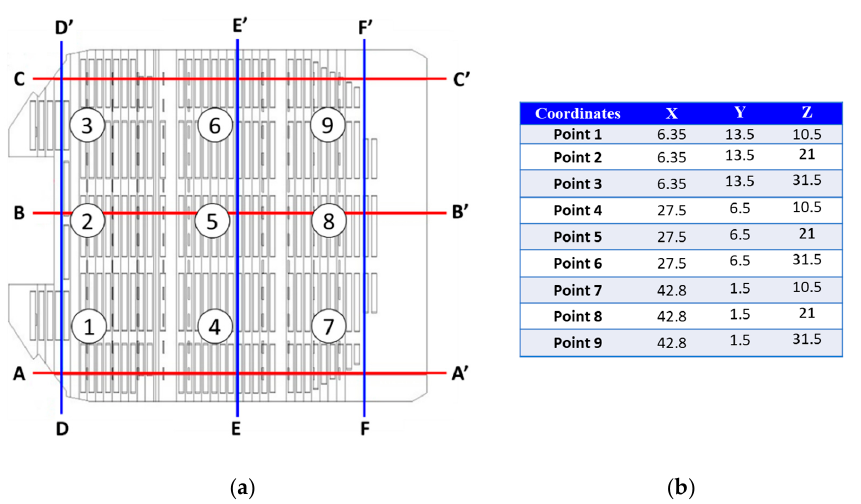
Figure 3. Testing location: ( a ) measurement points and cross-section plane and ( b ) coordinates points.